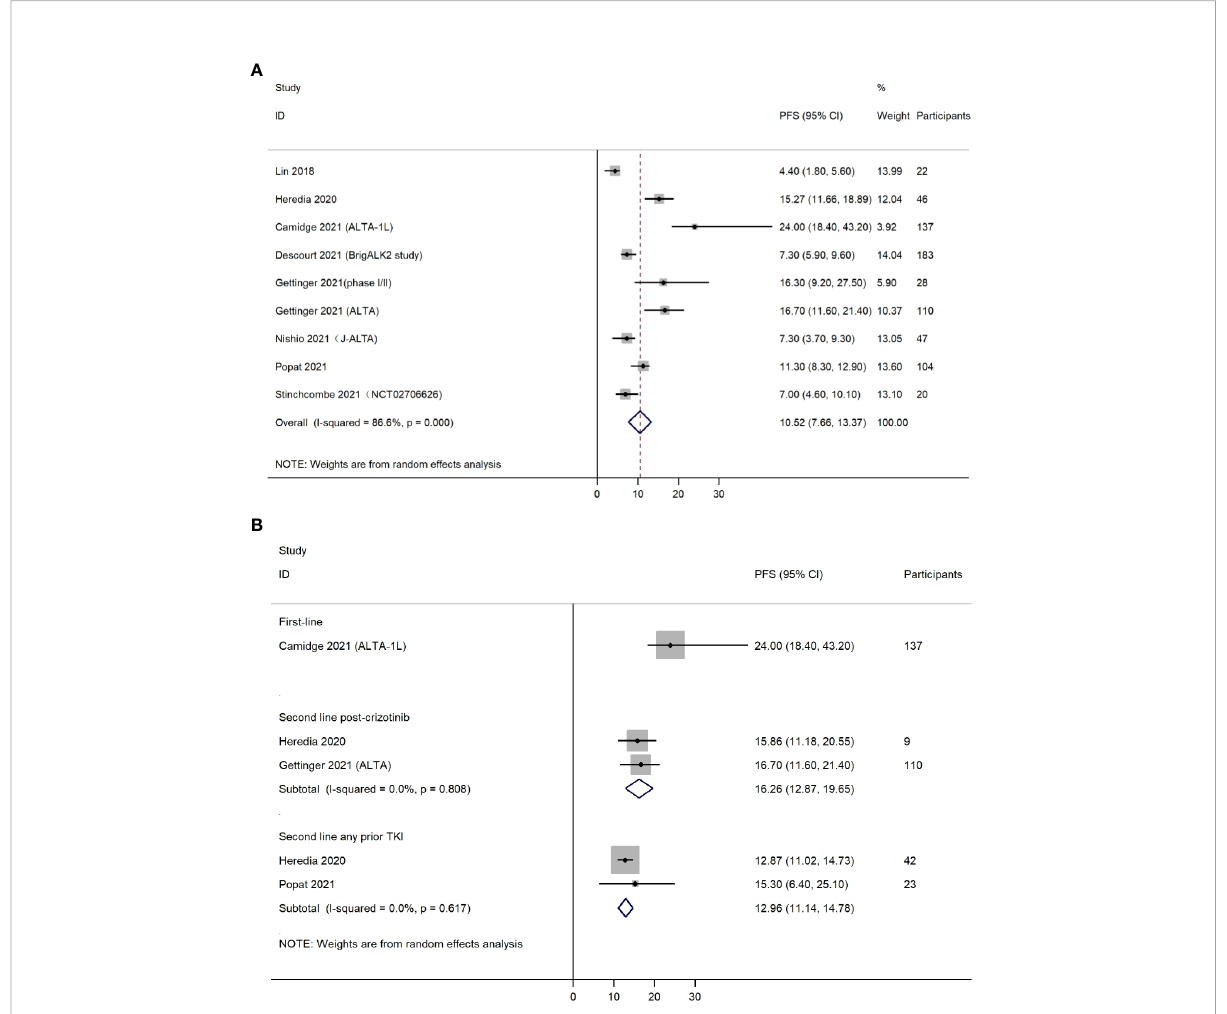
FIGURE 3 (A) Forest plot of overall progression free survival (PFS); (B) Forest plot of progression free survival (PFS) by treatment